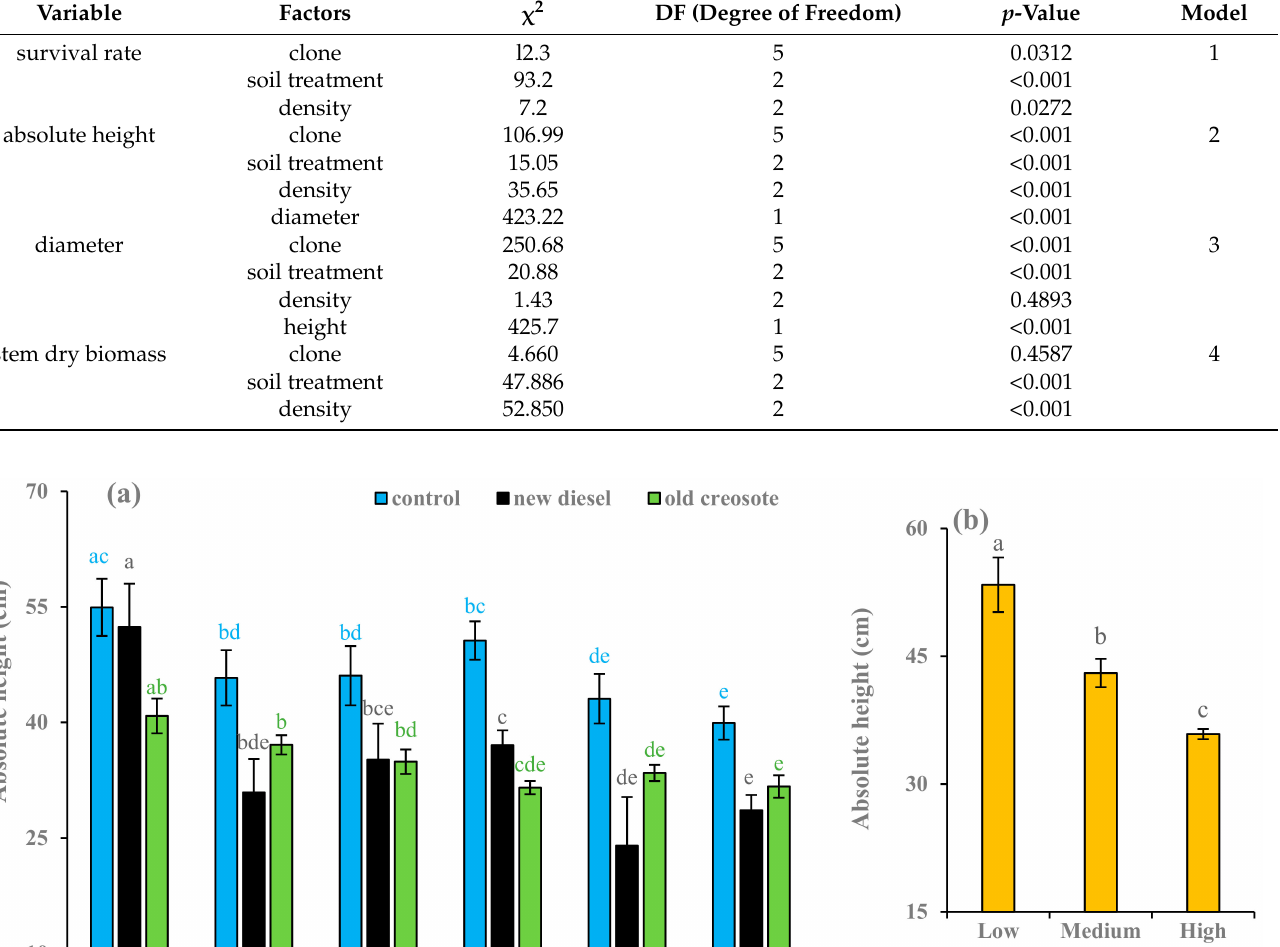
Table 2. Analysis of deviance (ANOVA).